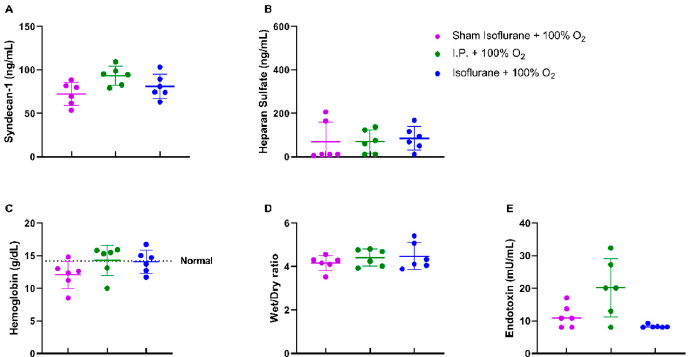
Figure 7. Isoflurane anesthesia did not have a protective effect on the endothelial glycocalyx either directly: plasmatic syndecan-1 ( A ) and heparan sulfate ( B ) or indirectly: hemoglobin concentration ( C ), reperfusion edema (wet/dry ratio, ( D )), and bacterial translocation (plasmatic endotoxin levels, ( E )). ( n = 6/group). I.P.: intraperitoneal injection anesthesia; O 2 : oxygen. Normal value is shown by a horizontal dashed line in graph ( C ).